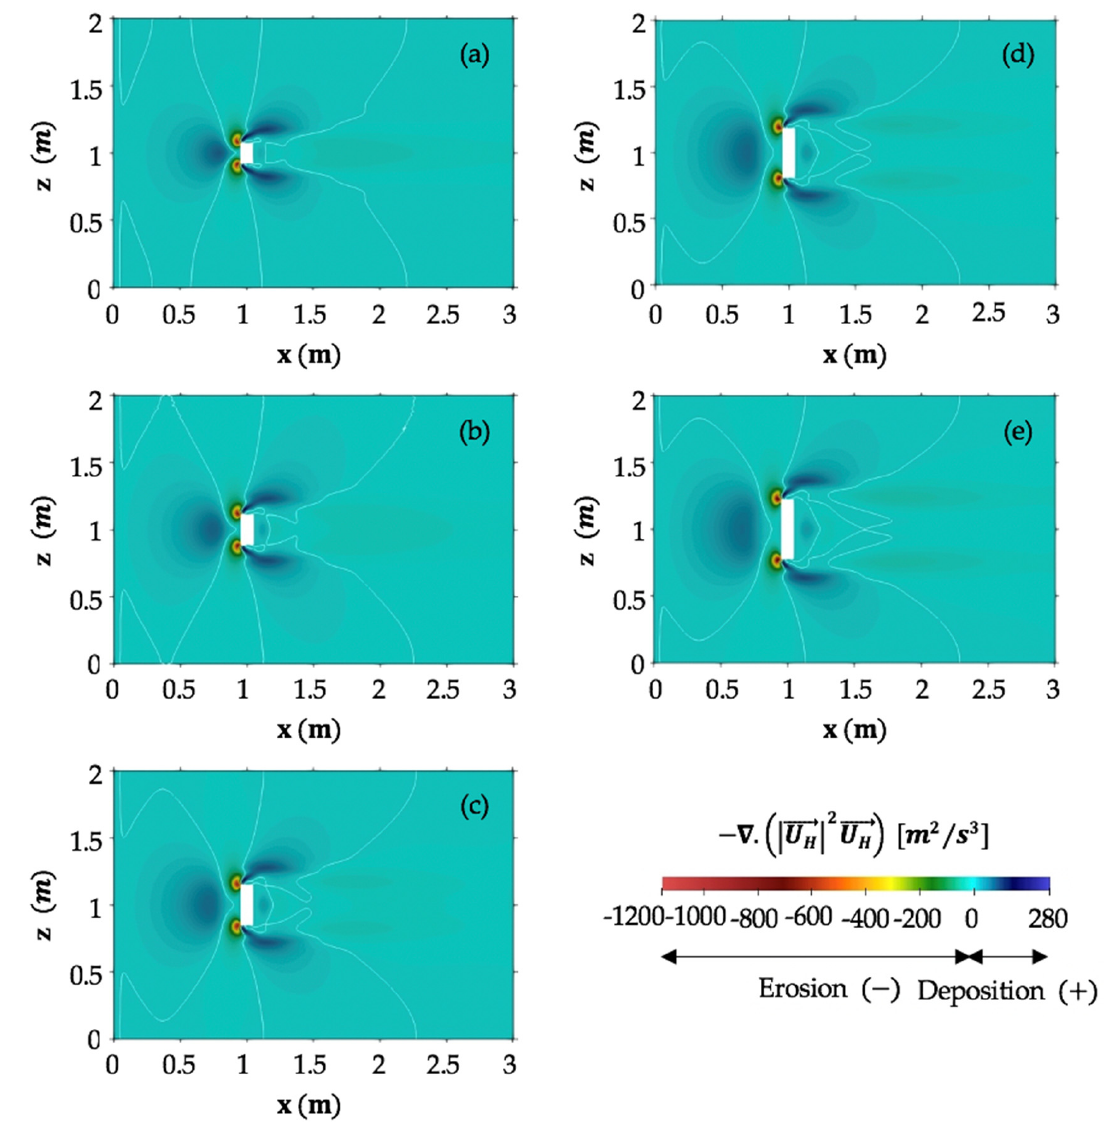
Figure 11. The Impact of building width on erosion and deposition patterns inferred from the convergence of the third-order horizontal wind velocity field at a near-surface plane, y = 0.0125 m. The building length and height are l (cid:48)(cid:48) and h (cid:48)(cid:48) , respectively. The building width, w (cid:48)(cid:48) , is varied as ( a ) w (cid:48)(cid:48) , ( b ) 1.5 w (cid:48)(cid:48) , ( c ) 2 w (cid:48)(cid:48) , ( d ) 2.5 w (cid:48)(cid:48) , and ( e ) 3 w (cid:48)(cid:48) . The impact of building height on bed morphology is investigated using Figure